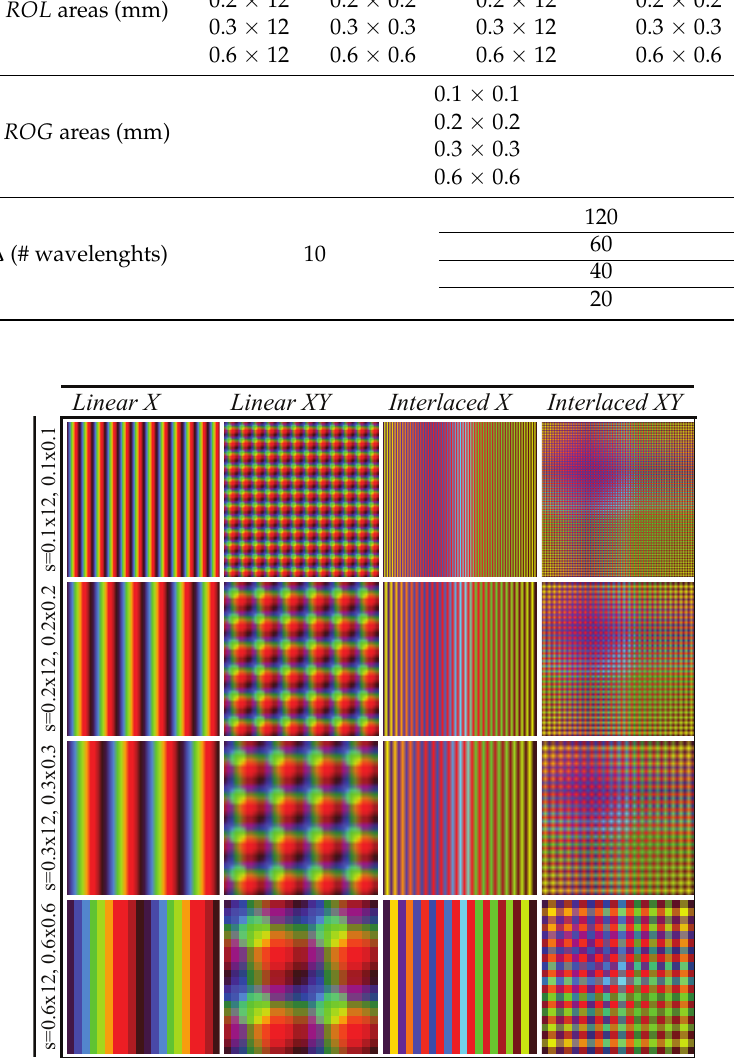
Figure 12. Samples of lighting patterns generated by the transformation υ Φ used in the